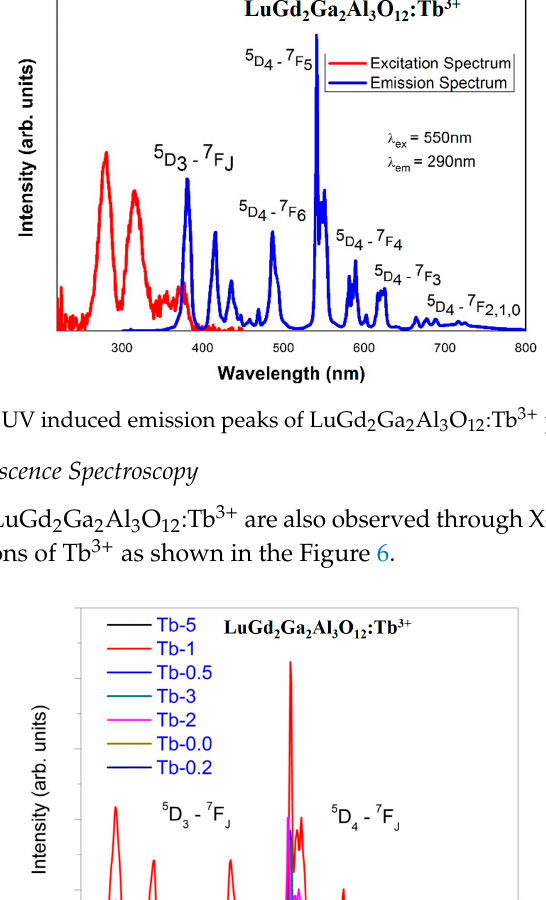
Figure 4. Excitation and Emission spectra of LuGd 2 Ga 2 Al 3 O 12 :Tb 3+ phosphor by UV light.